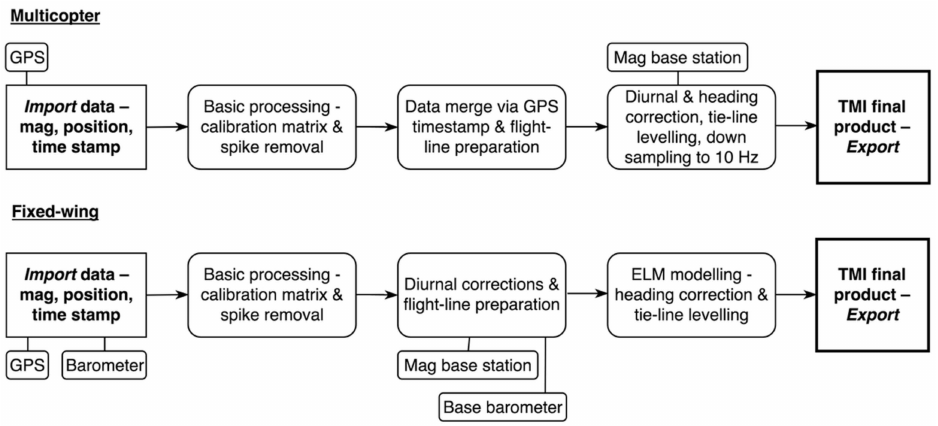
Figure 4. Principal magnetic processing workflows for UAS surveys. The workflows di ff er slightly, and the ELM technique is not applied on the multicopter data for this